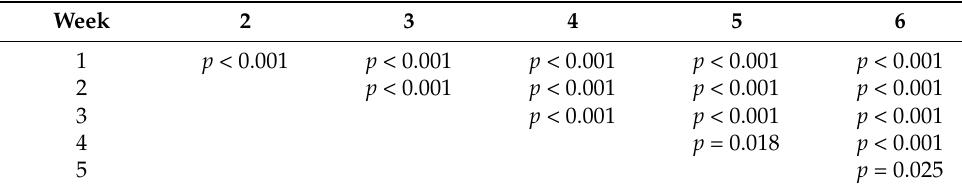
Table 1. p values results from one-way analysis of variance ANOVA.